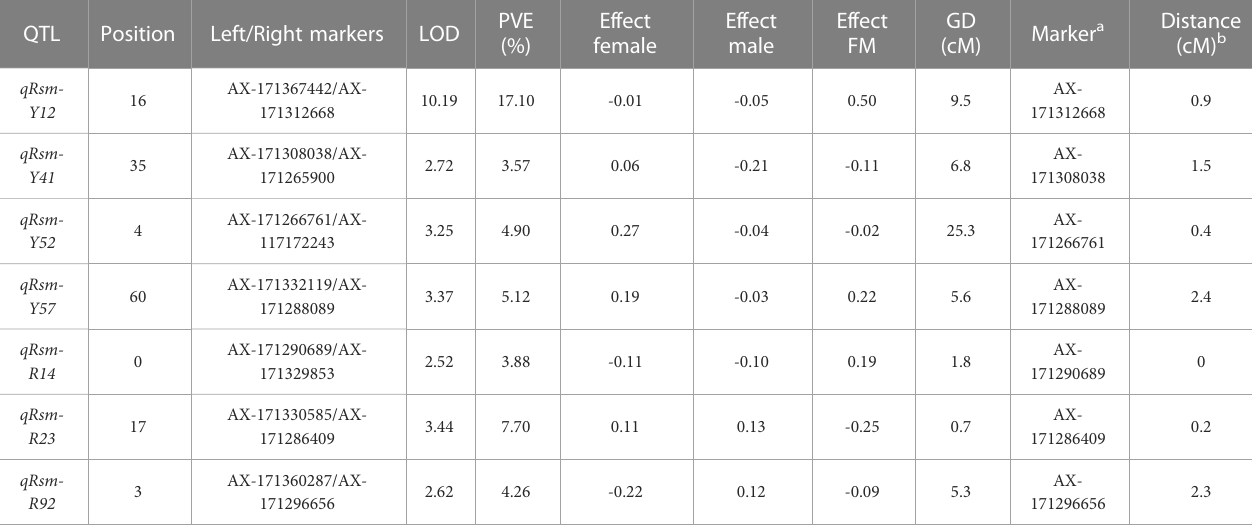
TABLE 3 SMD resistance-related QTLs in a F 1 progeny mapping population from the YT93-159 × ROC22 cross. QTL Position Left/Right markers LOD